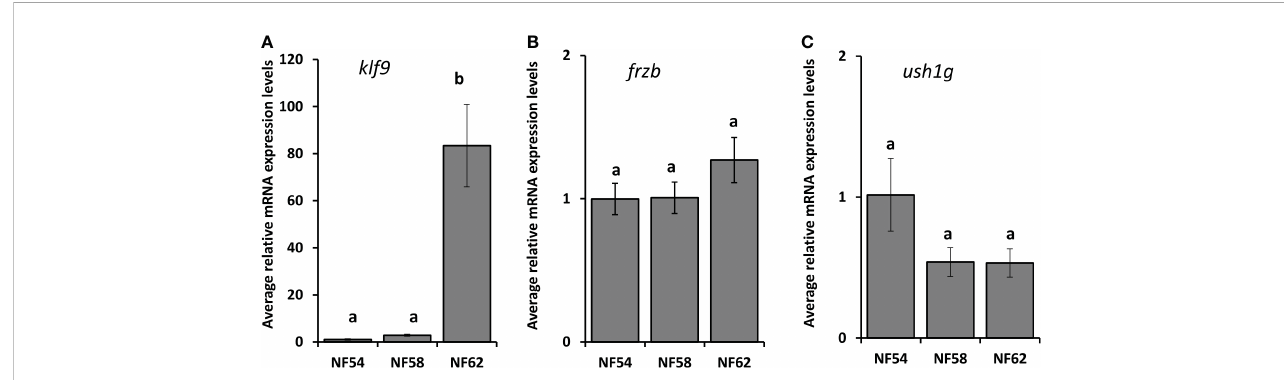
FIGURE 4 Developmental expression pro fi le of klf9, frzb , and ush1g in tadpole tails throughout metamorphosis. Tails from tadpoles at the indicated NF stages were harvested, followed by tail RNA extraction and quantitative PCR to measure mRNA expression levels of klf9 (A) , frzb (B) , ush1g (C) and the housekeeping gene rpl8 . Bars represent mean mRNA levels relative to rpl8 and normalized to a vehicle control sample. n = 10 tail samples per treatment. Error bars represent SE. Letters indicate signi fi cant groups, p < 0.05.